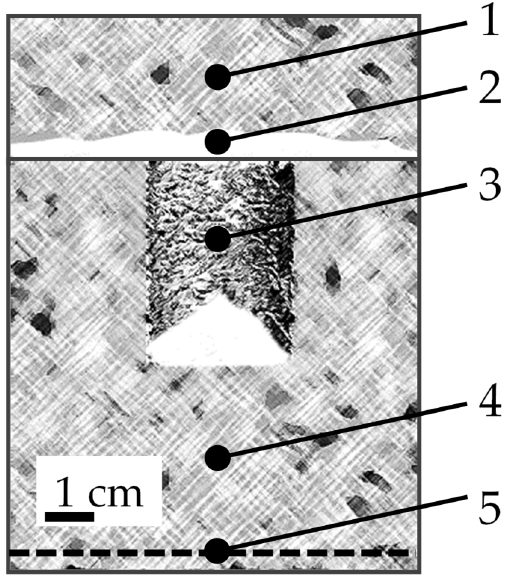
Figure 2. The position of test specimens: 1—plate is used for SEM and EDS; 2—a protective layer had formed on the surface of the plate; 3—cavity with K 2 CO 3 salt; 4—the crucible method test sample; 5—unreacted castable layer was used for XRD analysis.